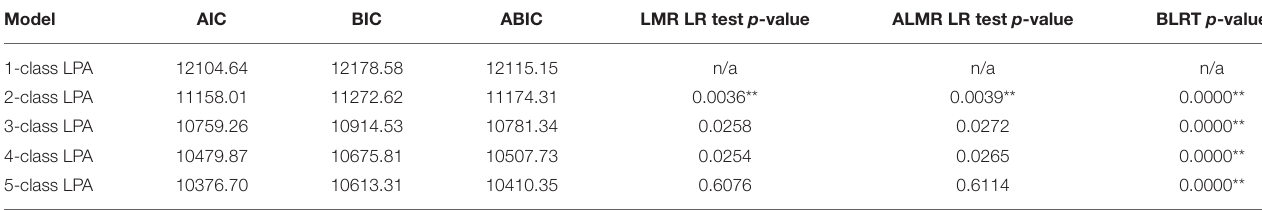
TABLE 1 | Comparison of different latent profile analysis